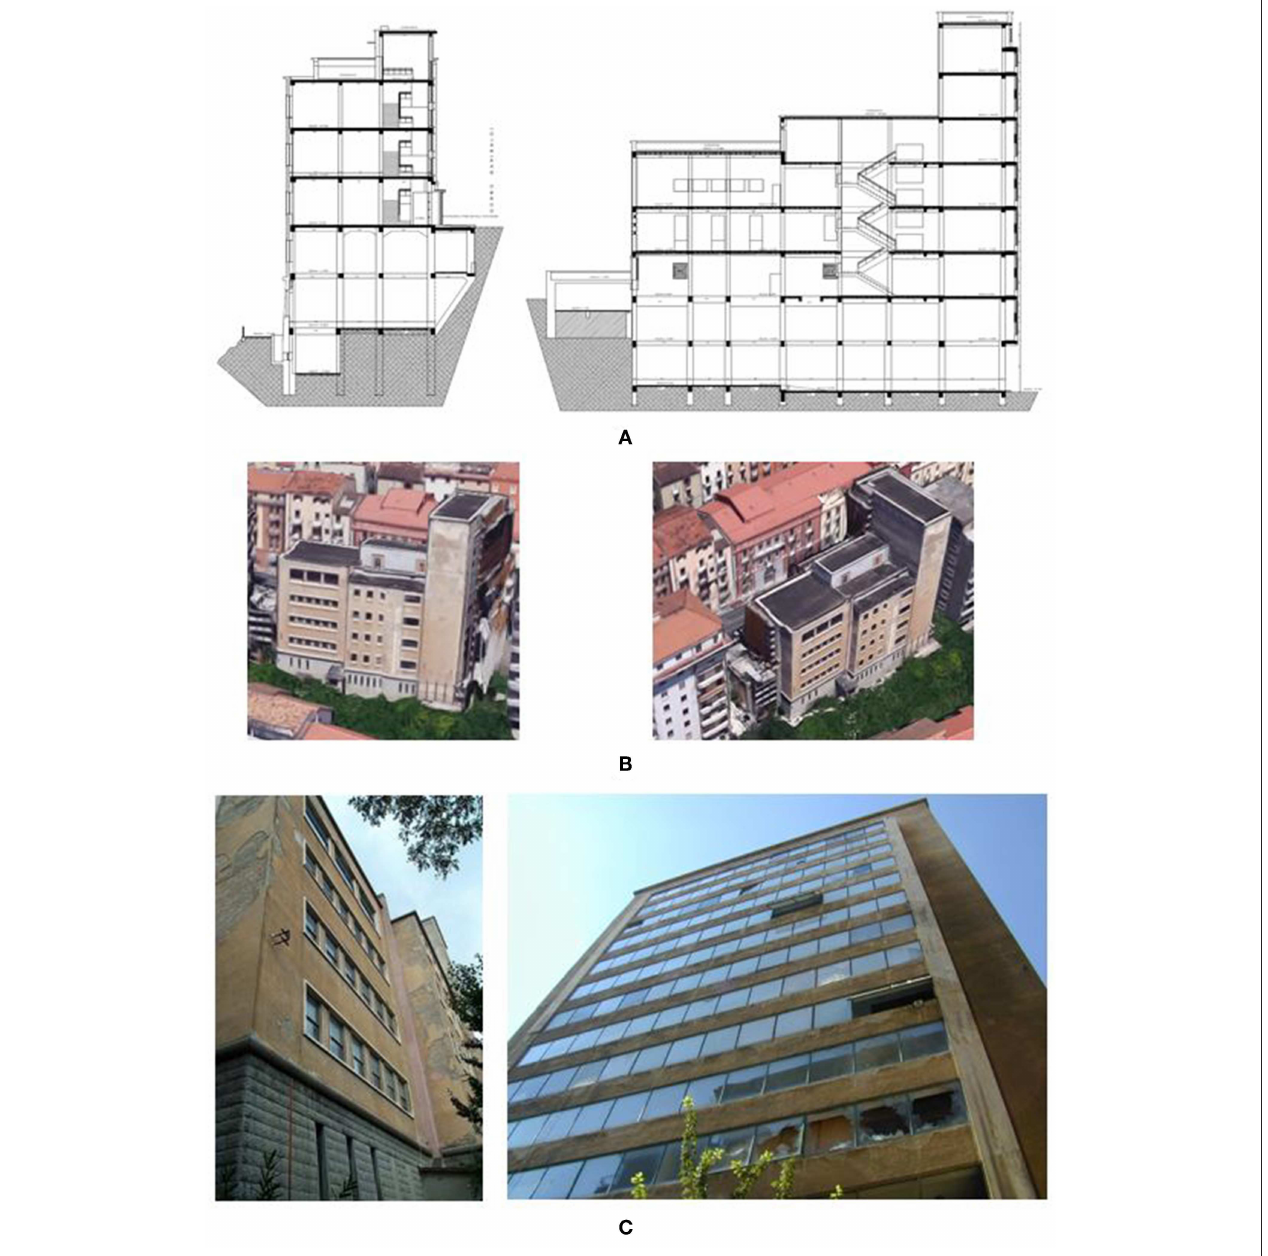
FIGURE 1 | Some images of the considered case study. (A) Transversal and longitudinal section of the building, (B) images from Google Maps (2019), and (C) current conditions of the building.